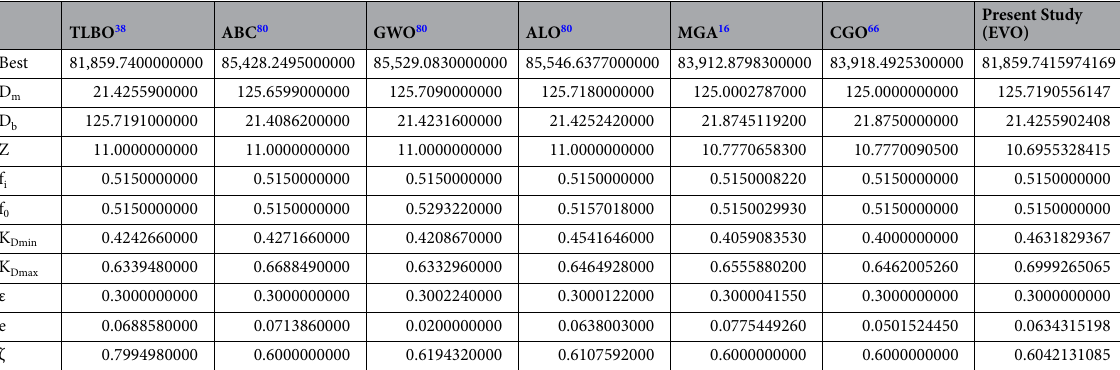
Table 14. Comparison of the best solutions for the rolling element bearing design problem. pitch diameter (Dm),ball diameter (Db), total number of balls (Z), inner raceway curvature coefficient (fi), and the outer raceway curvature coefficient (f0). ABC Artificial bee colony, GWO Grey wolf optimizer, ALO Ant lion optimizer.